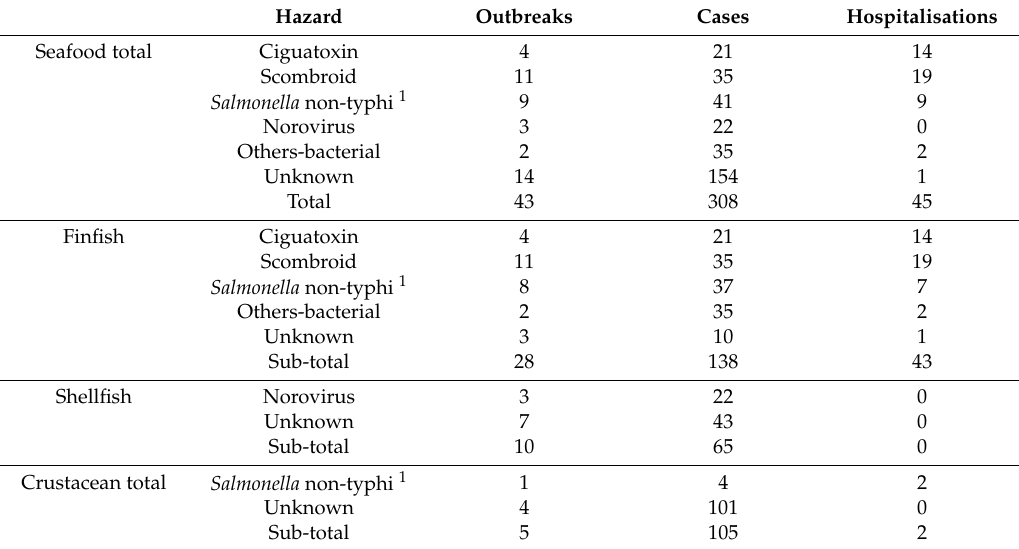
Table 2. Summary of NSW foodborne illness outbreaks attributed to seafood